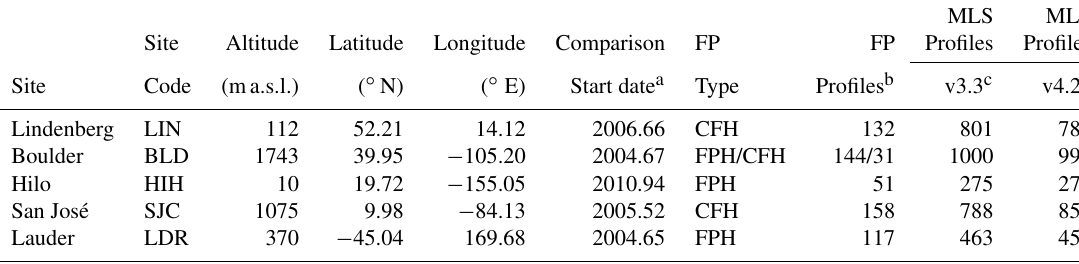
Table 1. Frost point hygrometer site information and coincident MLS profile statistics.